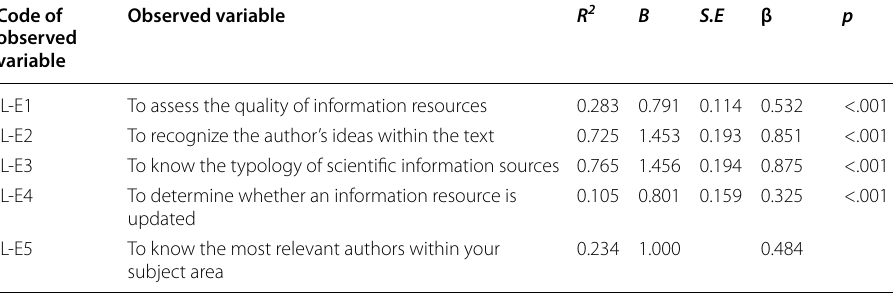
IL-E perceived information evaluation literacy, R 2 coefficient of determination, B unstandardized coefficient, S.E. standard error for unstandardized beta, β standardized beta, p probability